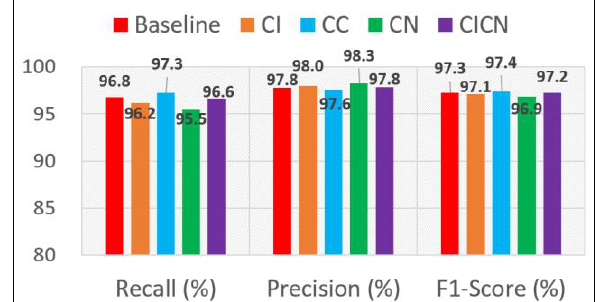
Figure 7 . The effect on different features on building detection.